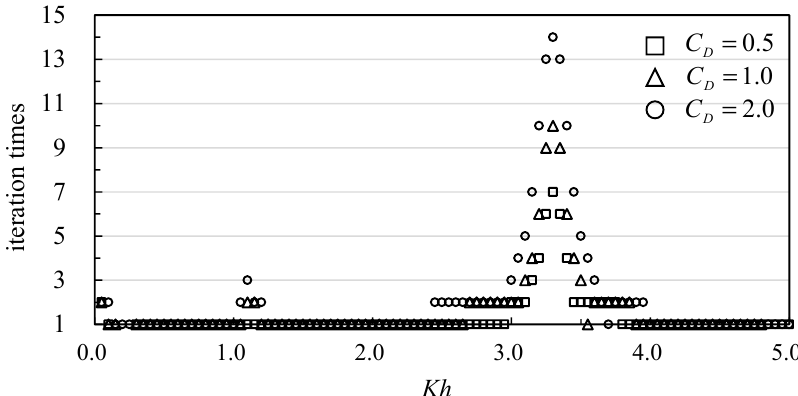
Figure 6. Iteration number versus relative water depth for different drag coefficients ( d 1 / h = 0.25, (cid:96) / h = 0.2, a / h = 0.3, C = 2.0, and C = D M